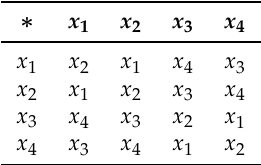
Table 1. Binary operation output. x 1 = Information Technology, x 2 = Professional Consulting, x 3 = Financial Services, x 4 = Health Care.